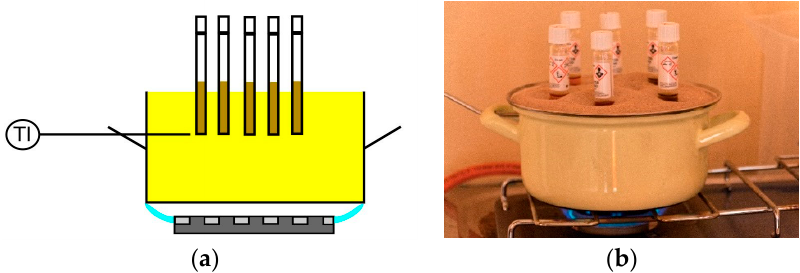
Figure 1. Gas stove sand bath digestion system. ( a ) Scheme of the digestion system; ( b ) picture of the system during a field test.